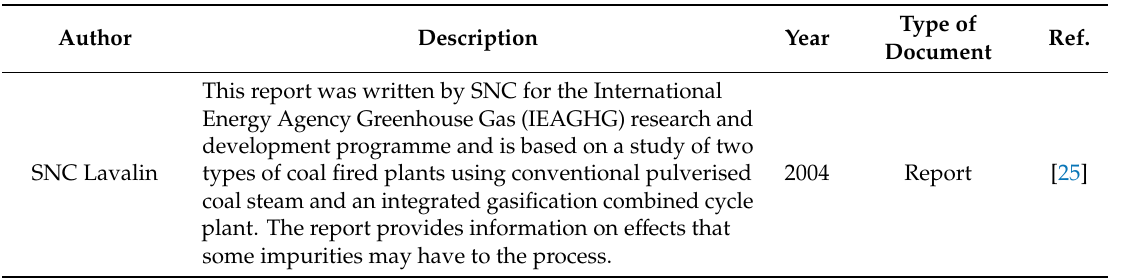
Table 4. List of CCS projects providing purity specifications. USA, United States of America; UK, United